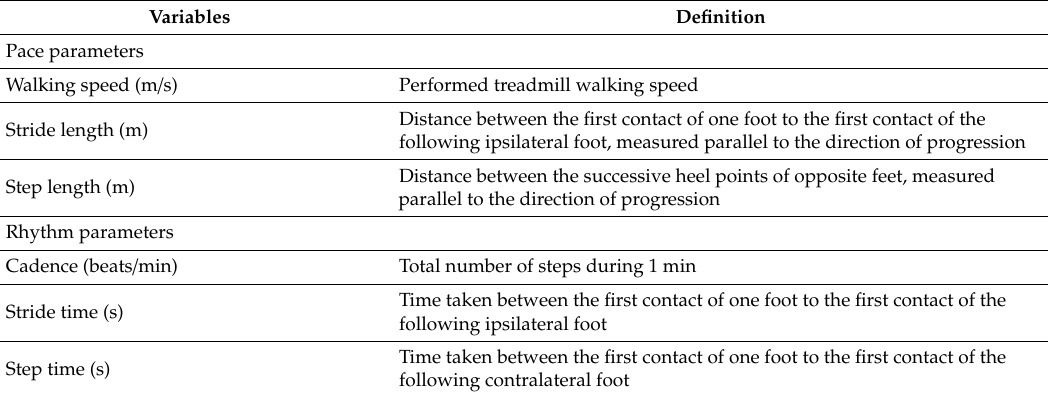
Table 2. Definitions of the gait-related